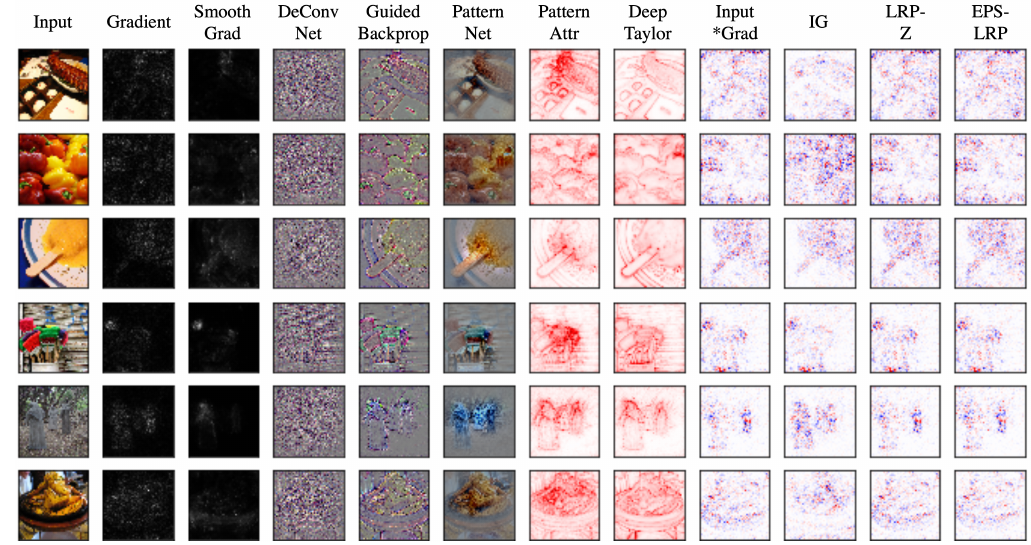
Figure 3. Attributions of VGG-16 with images from Imagenet using the methods implemented in